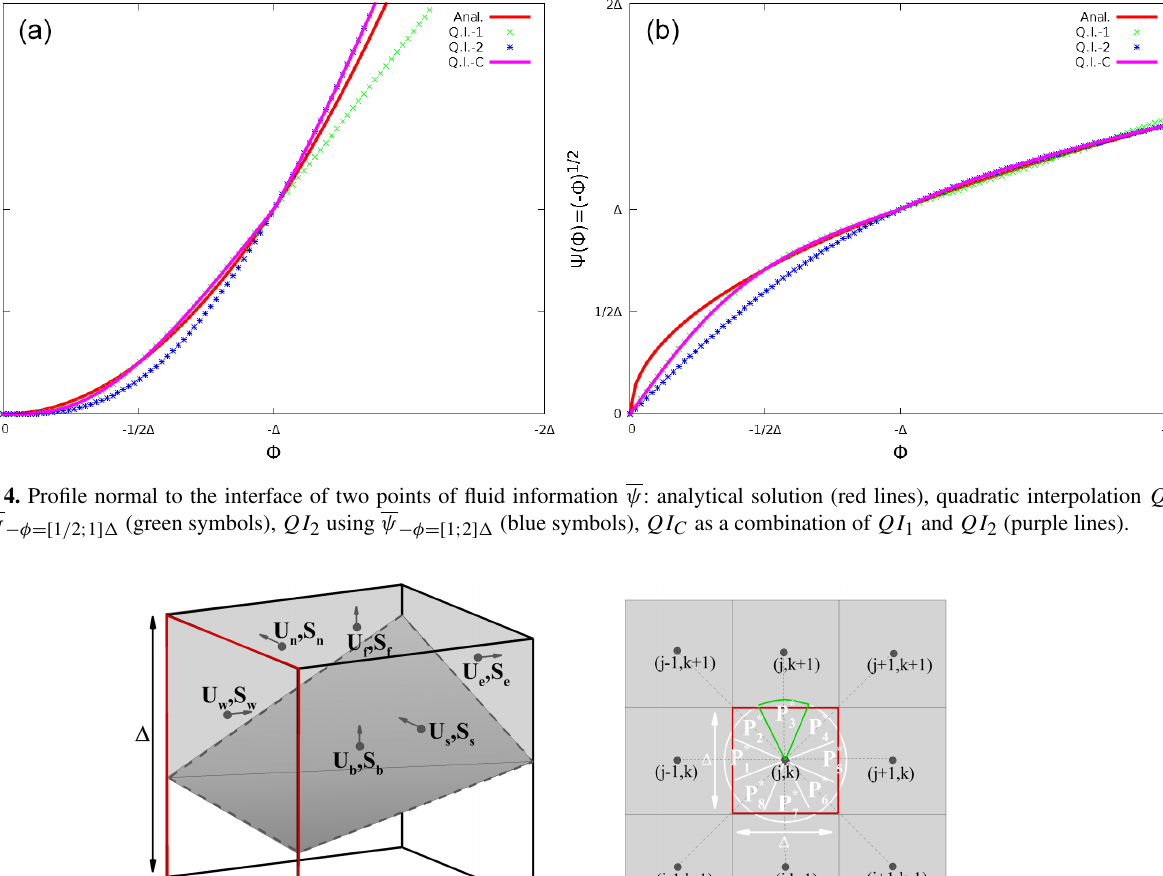
is indicated in green). 3